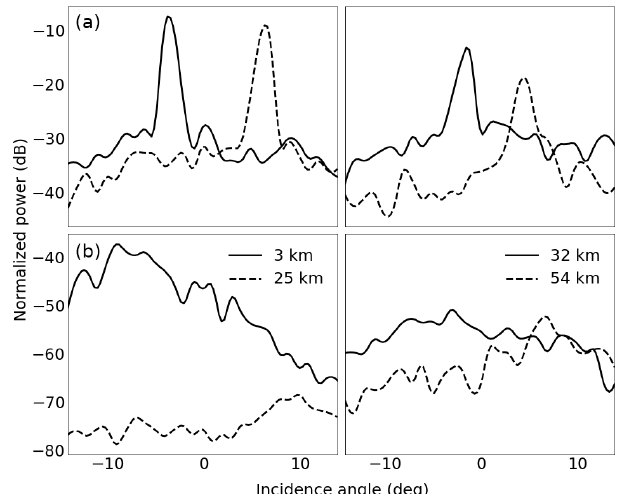
Figure 5. Internal layer (a) and bed (b) returns for track 1 at az- imuth positions x = ( 3 , 9 , 46 , 59 ) km, marked with vertical red lines in Fig. 3a. Quadratic interpolation was applied to smooth the signa- tures.